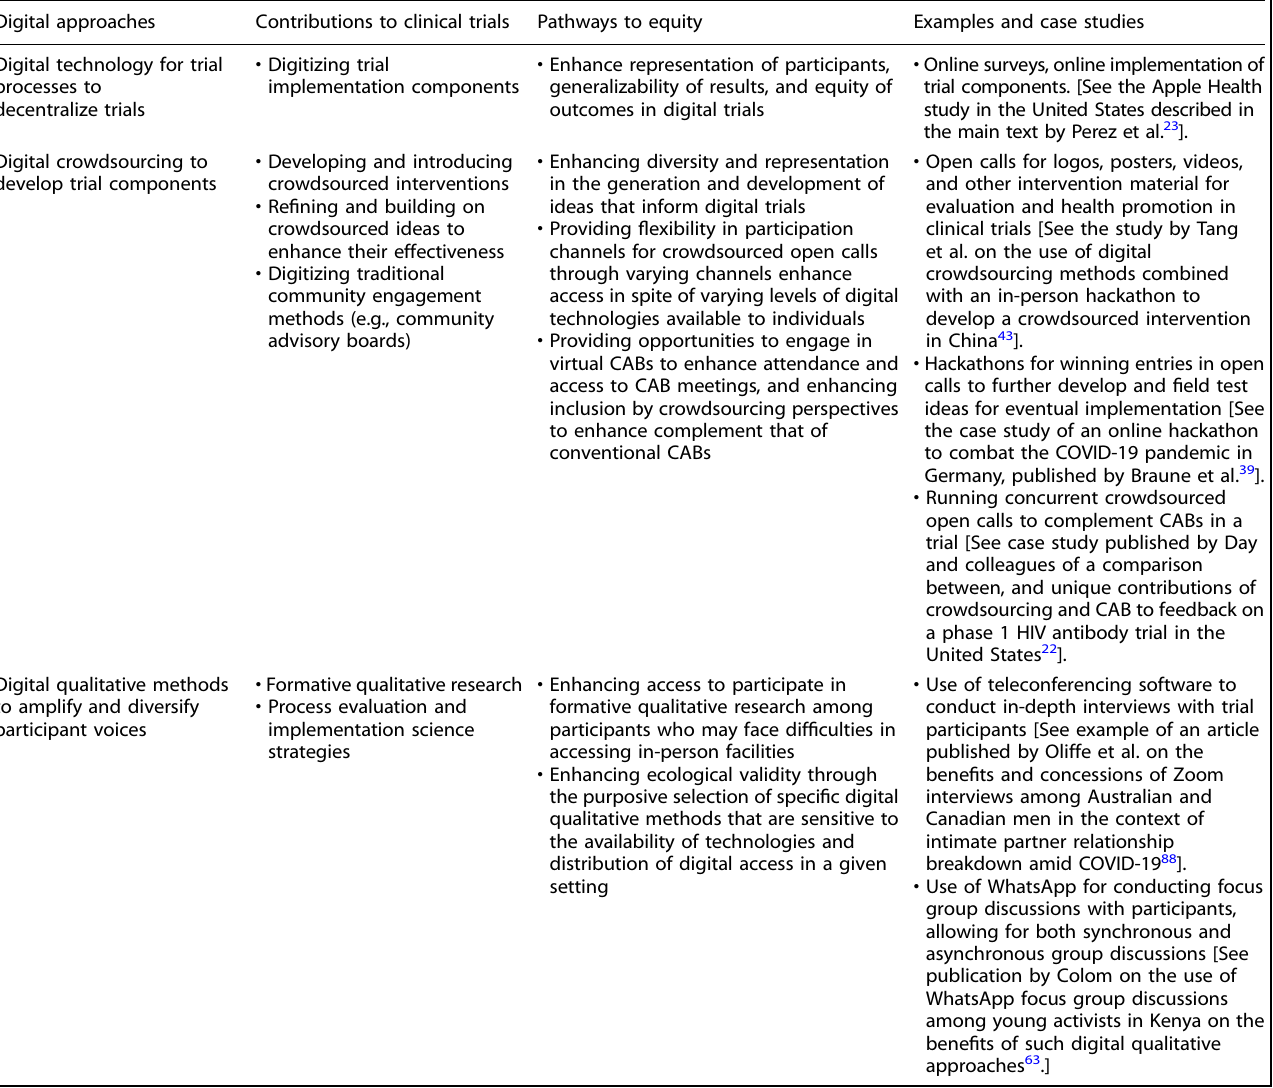
Table 2. Digital community engagement methods and its role in enhancing equity in digital